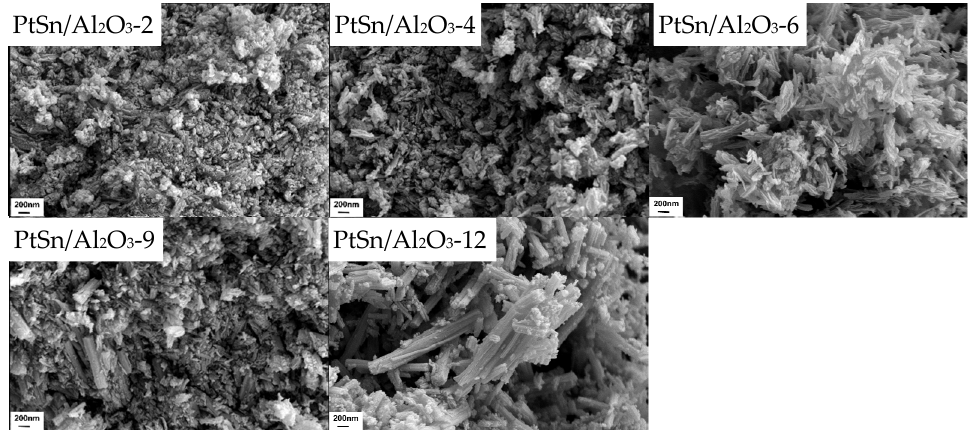
Figure 1. SEM images of PtSn/Al 2 O 3 catalysts.